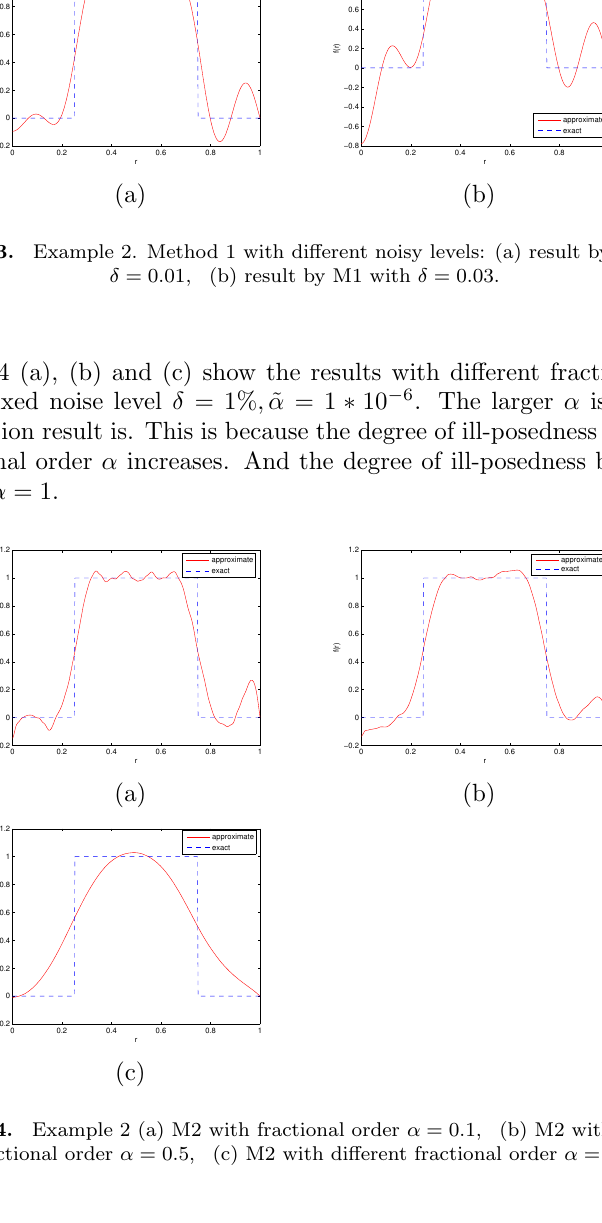
Figure 4. Example 2 (a) M2 with fractional order α = 0 . 1, (b) M2 with different fractional order α = 0 . 5, (c) M2 with different fractional order α = 0 .